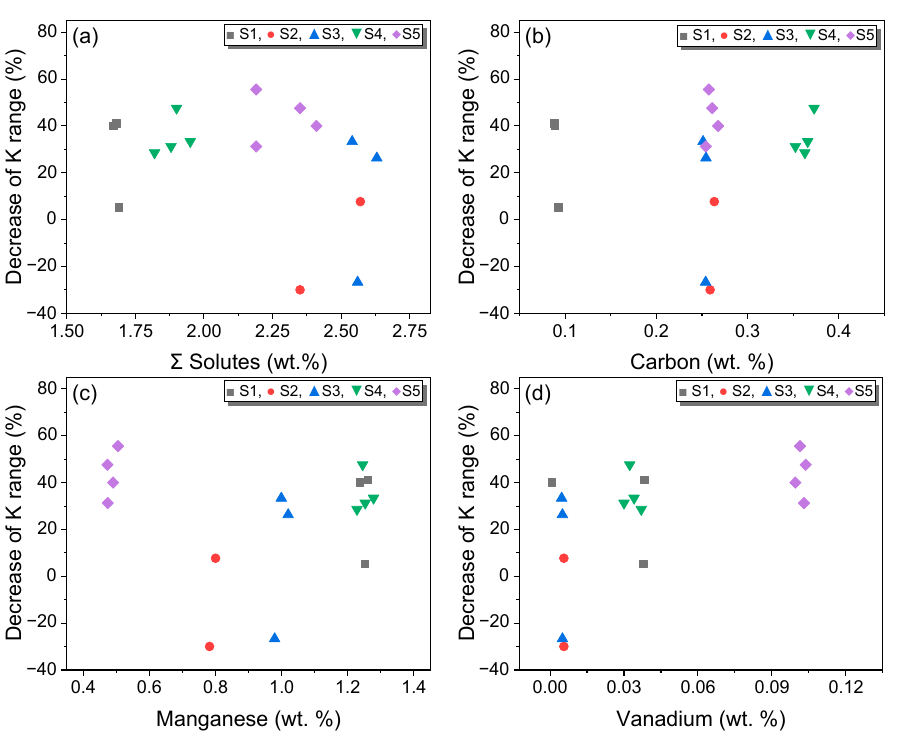
Figure 9. The decreasing percentage of carbon segregation ( K ) range in the radial direction of the billet via ( a ) the parameters of casting and ( b ) PMO.